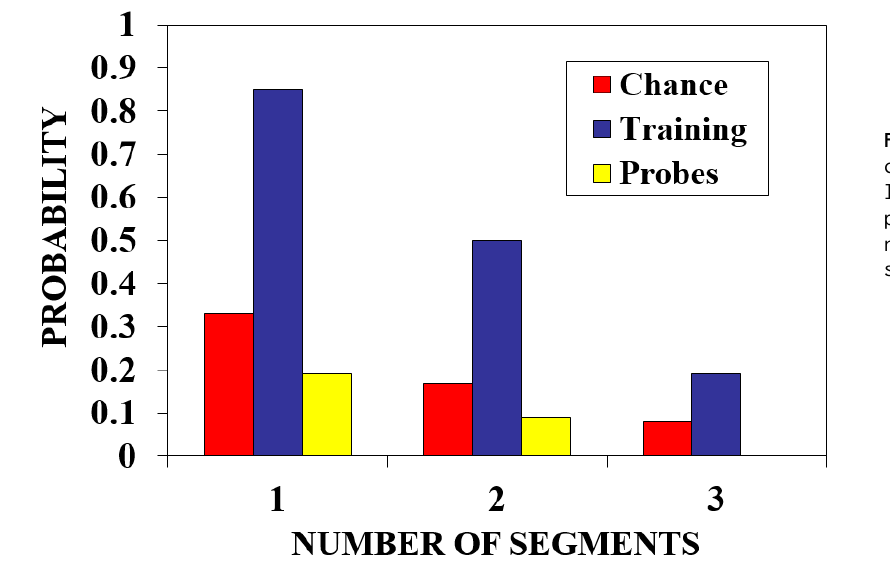
Figure 2 . Mean probability of a correct response (and chance levels) on training and novel probe trials, as a function of the number of line segments in the sample